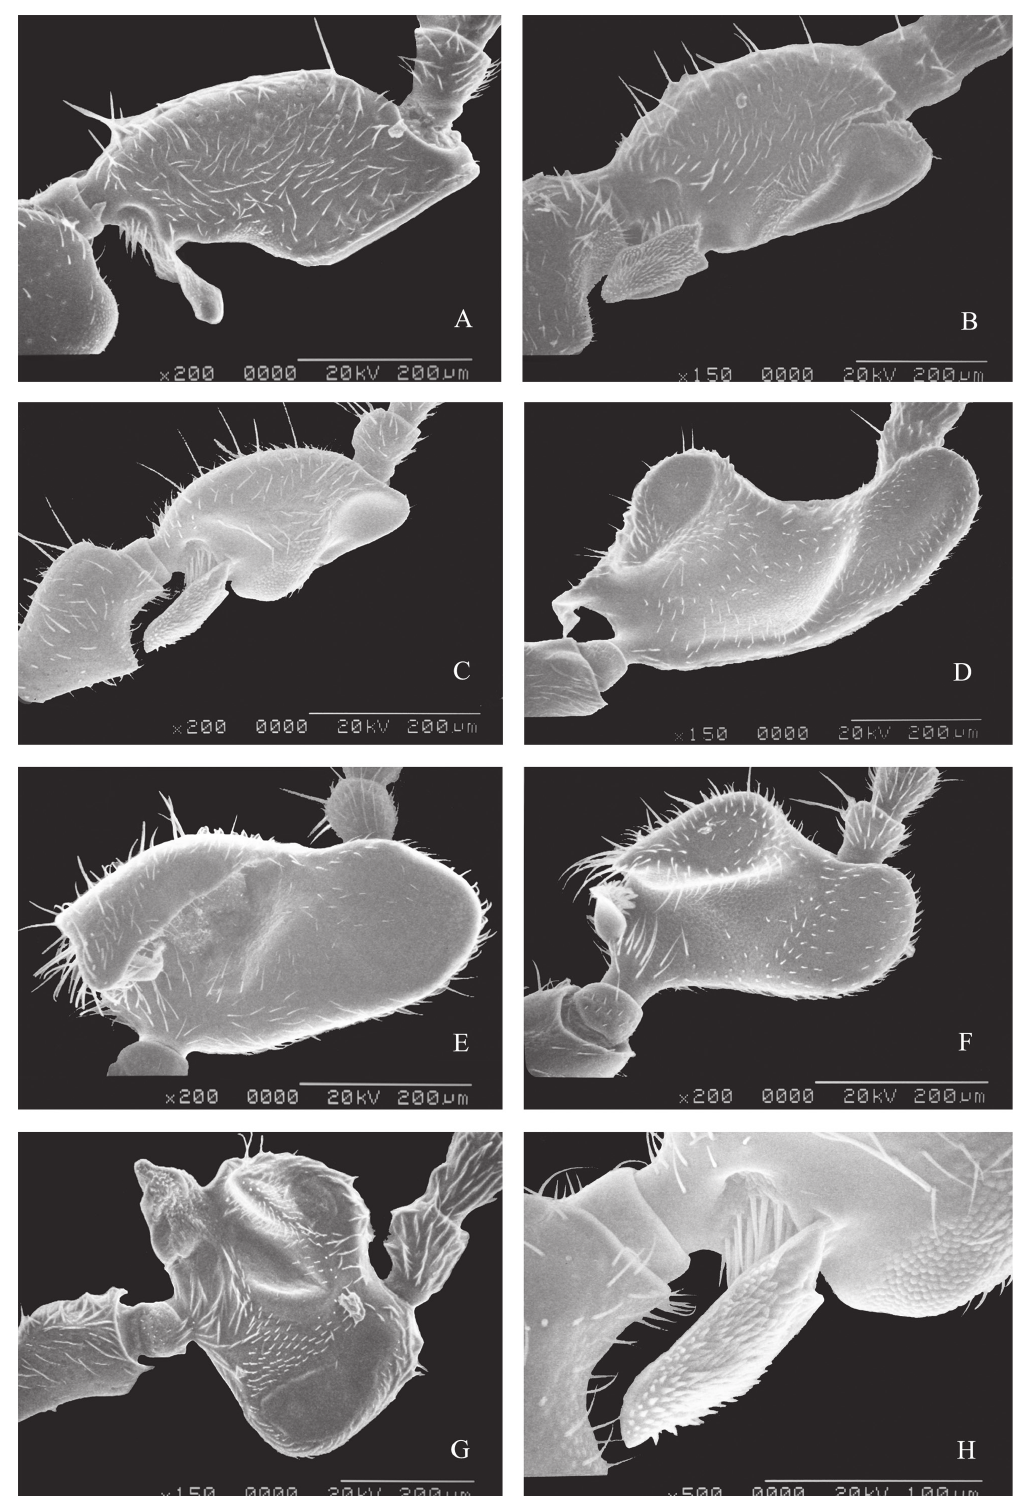
Fig. 6. SEM photographs of right male antennomere III of Intybia spp. A . Intybia histrio (Kiesenwetter, 1874). B . I. tsushimensis (Satô & Ohbayashi, 1968). C , H . I. donan sp. nov., showing projection